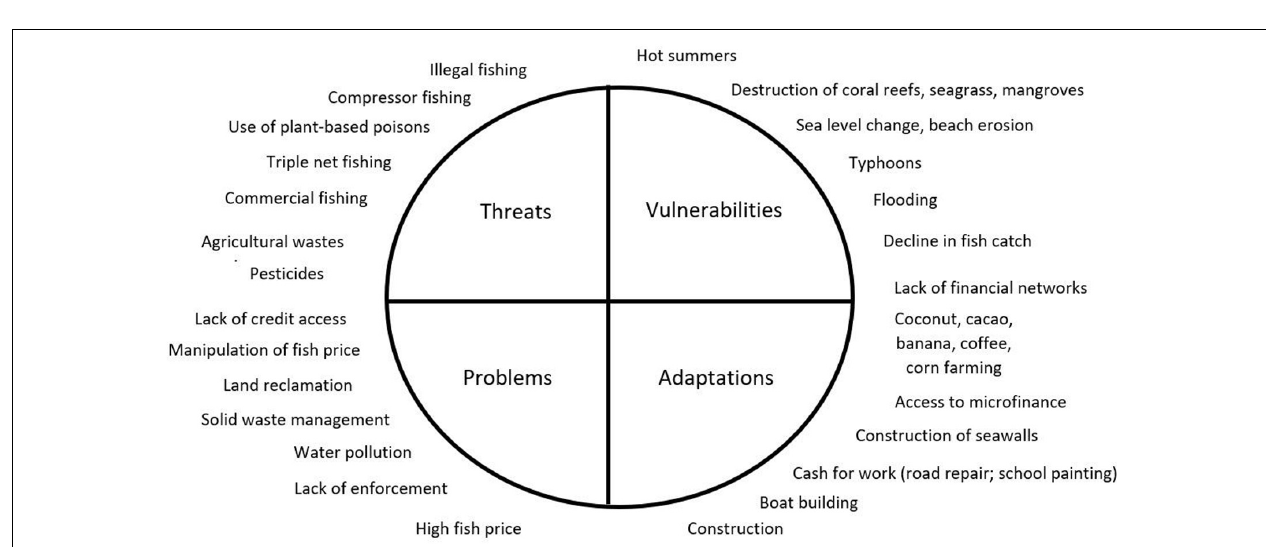
FIGURE 3 | Decadal catch of the fishers based on the survey with the number of respondents on the secondary y -axis ( N = 220).